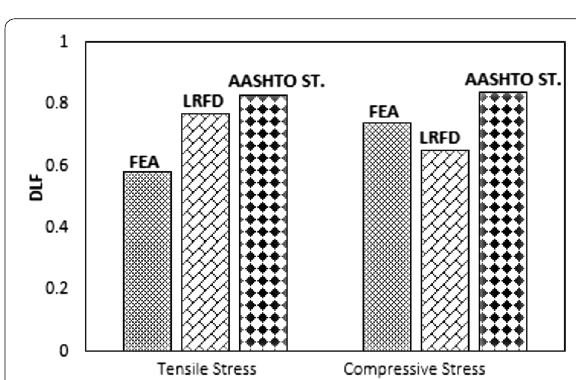
Fig. 13 Comparison of the LDF s obtained from various codes and